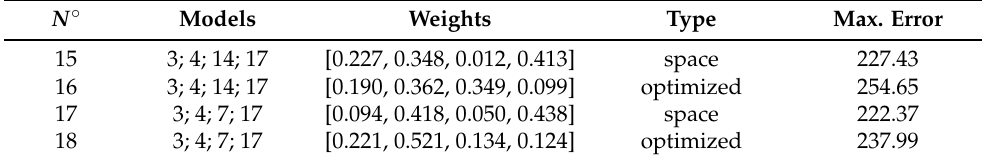
Table 17. Ensemble models tested using four single models and the maximum error